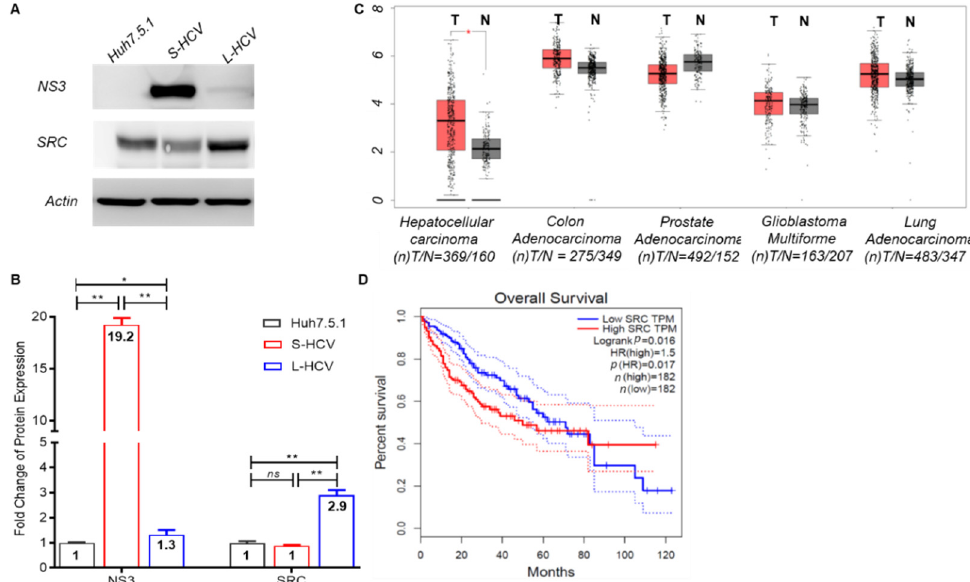
Figure 4. Clinical data associated with SRC , derived from Gene Expression Profiling Interactive Analysis (GEPIA). ( A ) Protein expression of NS3 and SRC in Huh7.5.1 cells, short-term HCV (S-HCV), and long-term HCV (L-HCV). Actin was used as a protein expression control. ( B ) Fold change in protein expression, statistical significance p < 0.05 *, p < 0.01 ** while values p > 0.05 were deemed non-significant (ns). ( C ) Clinical data demonstrating the regulation of SRC in liver hepatocellular carcinoma (LIHC), colon adenocarcinoma (COAD), prostate adenocarcinoma (PRAD), glioblastoma multiforme (GBM), and lung adenocarcinoma (LUAD). Red box indicates tumor (T) samples and gray box indicates non-tumor (N) samples. ( D ) Survival plot based on Kaplan–Meier analysis of SRC expression with survival outcomes. Transcripts Per Million (TPM) is a normalization method for RNA-seq. The logrank test is used for the hypothesis test in GEPIA. The hazard ratio (HR) is calculated based on Cox PH model, with the dotted lines representing the 95% confidence interval. The total number of samples is represented by n . Statistical significance p < 0.05 *. Table 3. Clinicopathological characteristics of HCV-HCC patients in a cohort treated with pegylated interferon (IFN). Clinical